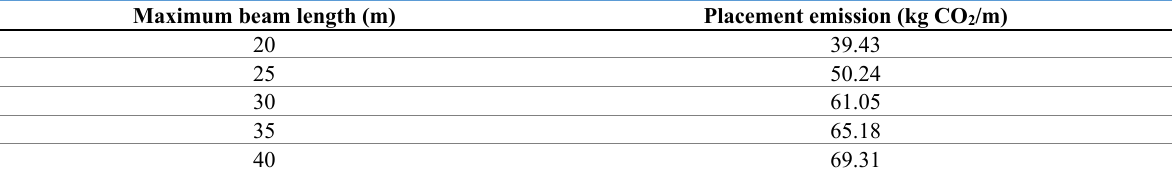
Table 10. CO 2 emissions from beam placement stage(distance up to 50 km, one way) [1].